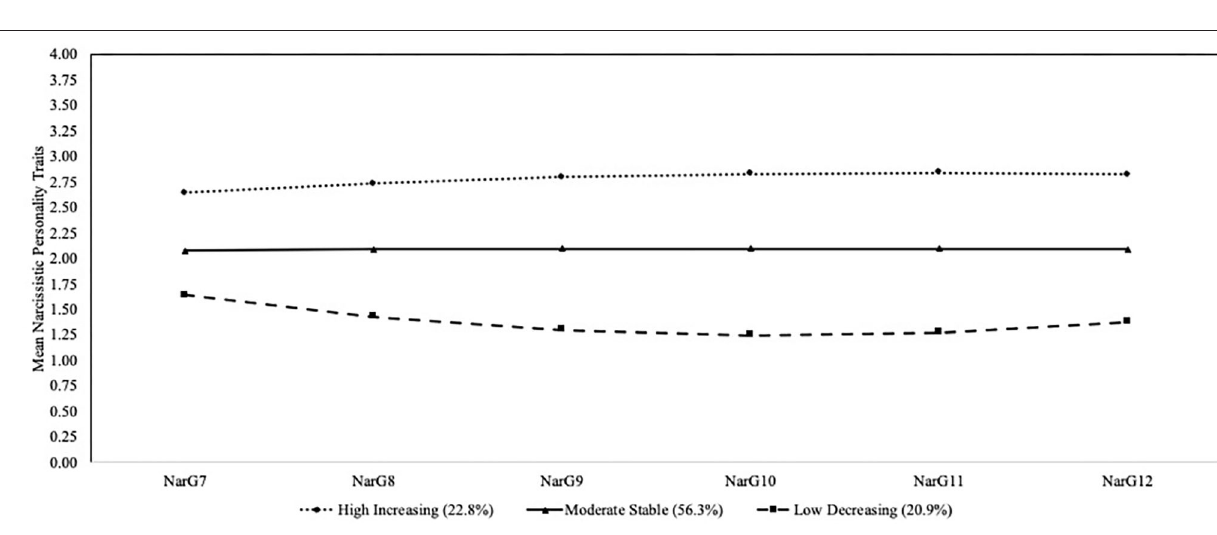
and narcissistic traits (low-risk; 19%, n = 115; 39 boys, 76